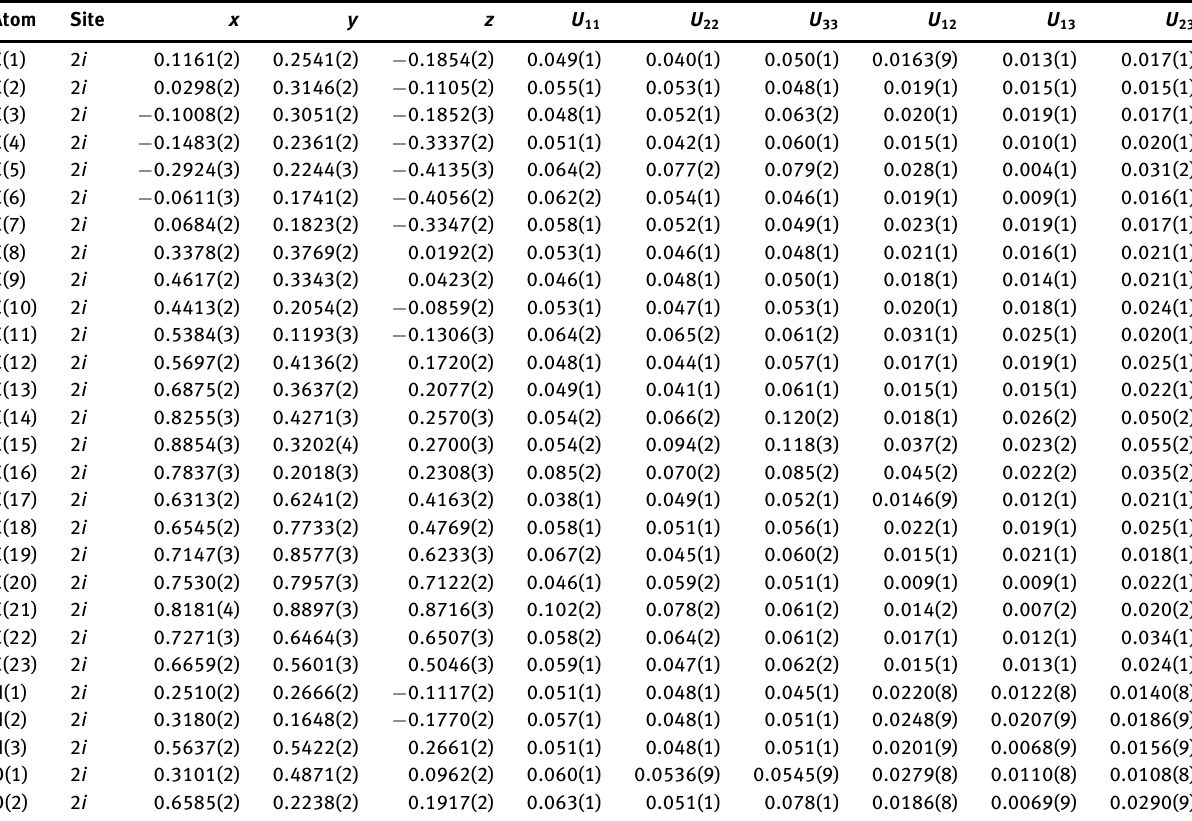
Table 3: Atomic displacement parameters (Å 2